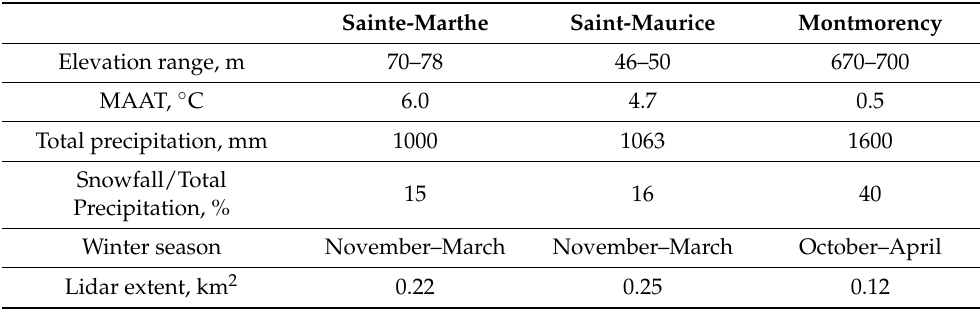
Figure 1. Overview of the study sites with lidar survey extents. ( a ) Sainte-Marthe; ( b ) Saint-Maurice; and ( c ) Montmorency. Manual measurement and ground control point (GCP) locations are also shown. (Manual measurements in Saint-Maurice could not be retrieved due to a probe malfunctioning, thus they are not shown). Contour intervals deliberately differed between sites for interpretation purposes. Table 1. Site characteristics and field campaign details.